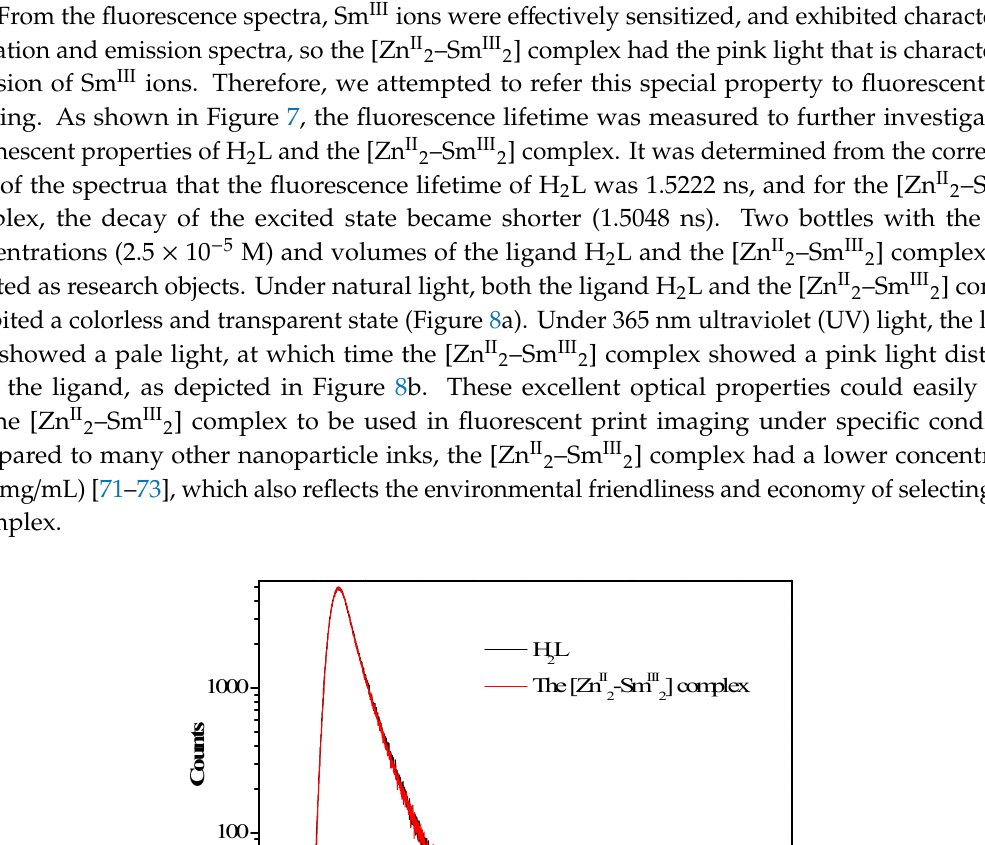
Figure 7. The Fluorescence lifetime of H 2 L and the [Zn II2 – Sm III2 ] complex.